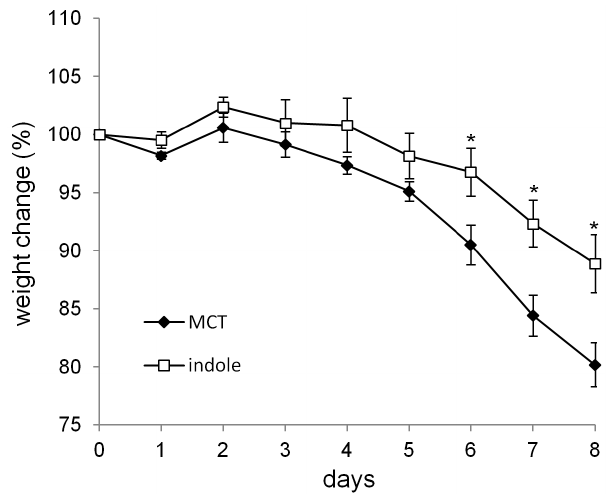
Figure 5. Indole-containing capsules show preventative effect on colitis development in SPF mice. SPF mice were treated with indole- (n=7) or MCT- (n=7) containing capsules for 1 week, and then challenged by 5% DSS for 6 days. Body weight changes relative to the value prior to colitis induction are shown. Data are representative of two independent experiments and mean 6 S.E.M of 7 mice at each time point is shown. *P , 0.05. MCT, Medium-Chain Triglycerides.